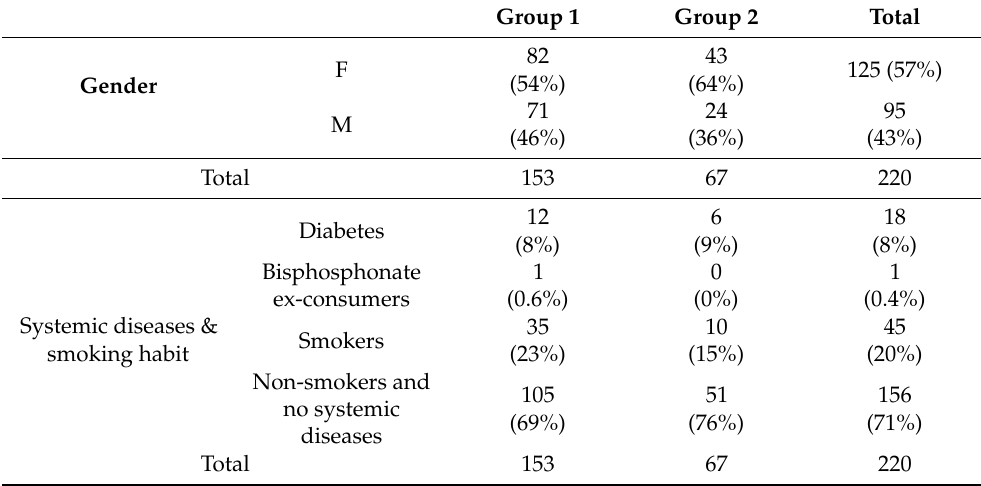
Table 4. Gender, systemic diseases and smoking habit distribution of Group 1 (EA ≥ 30 ◦ ) and Group 2 (EA < 30 ◦ )